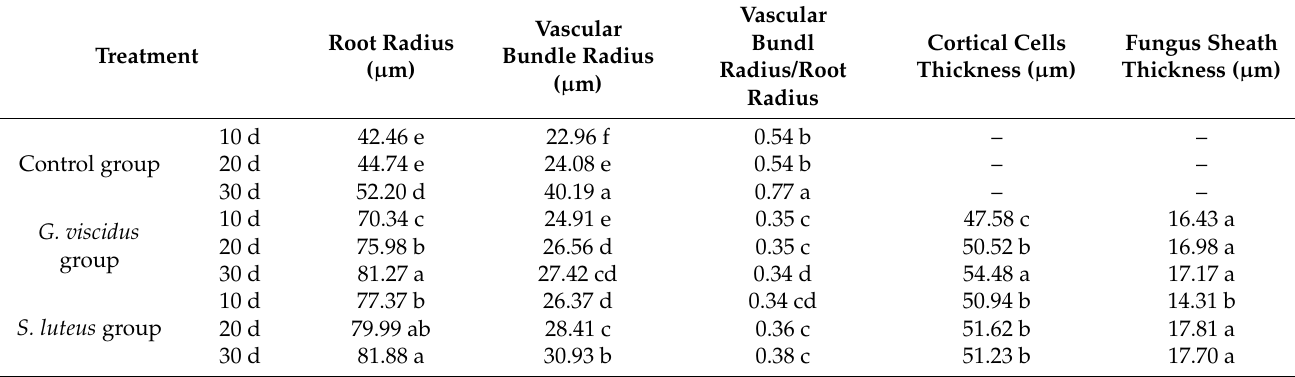
Note: Different lowercase letters within columns indicate significant differences at p < 0.05.